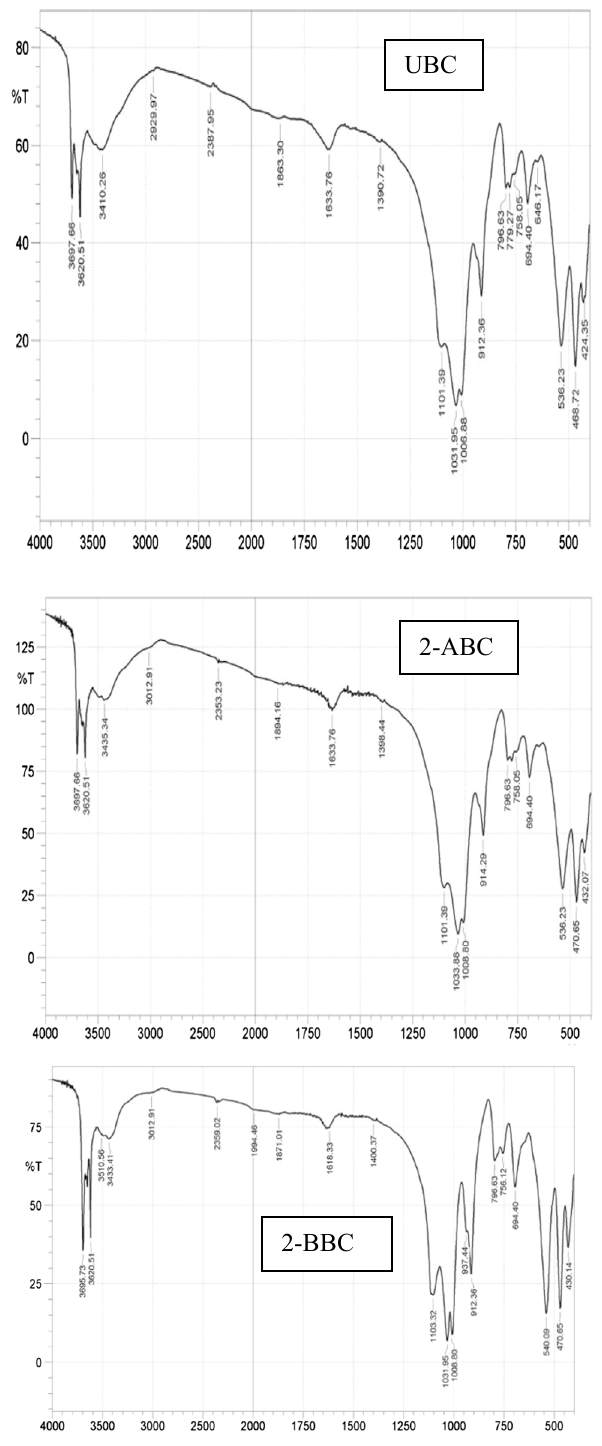
Fig. 2 FTIR spectra of various bentonite